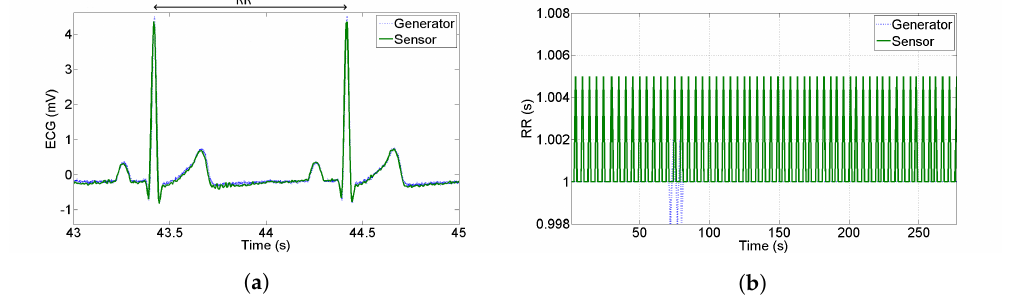
Figure 7. ( a ) Comparison between the synthesized peaks acquired from the oscilloscope and the proposed sensor, and ( b ) tachogram extraction to evaluate the jitter introduced by the